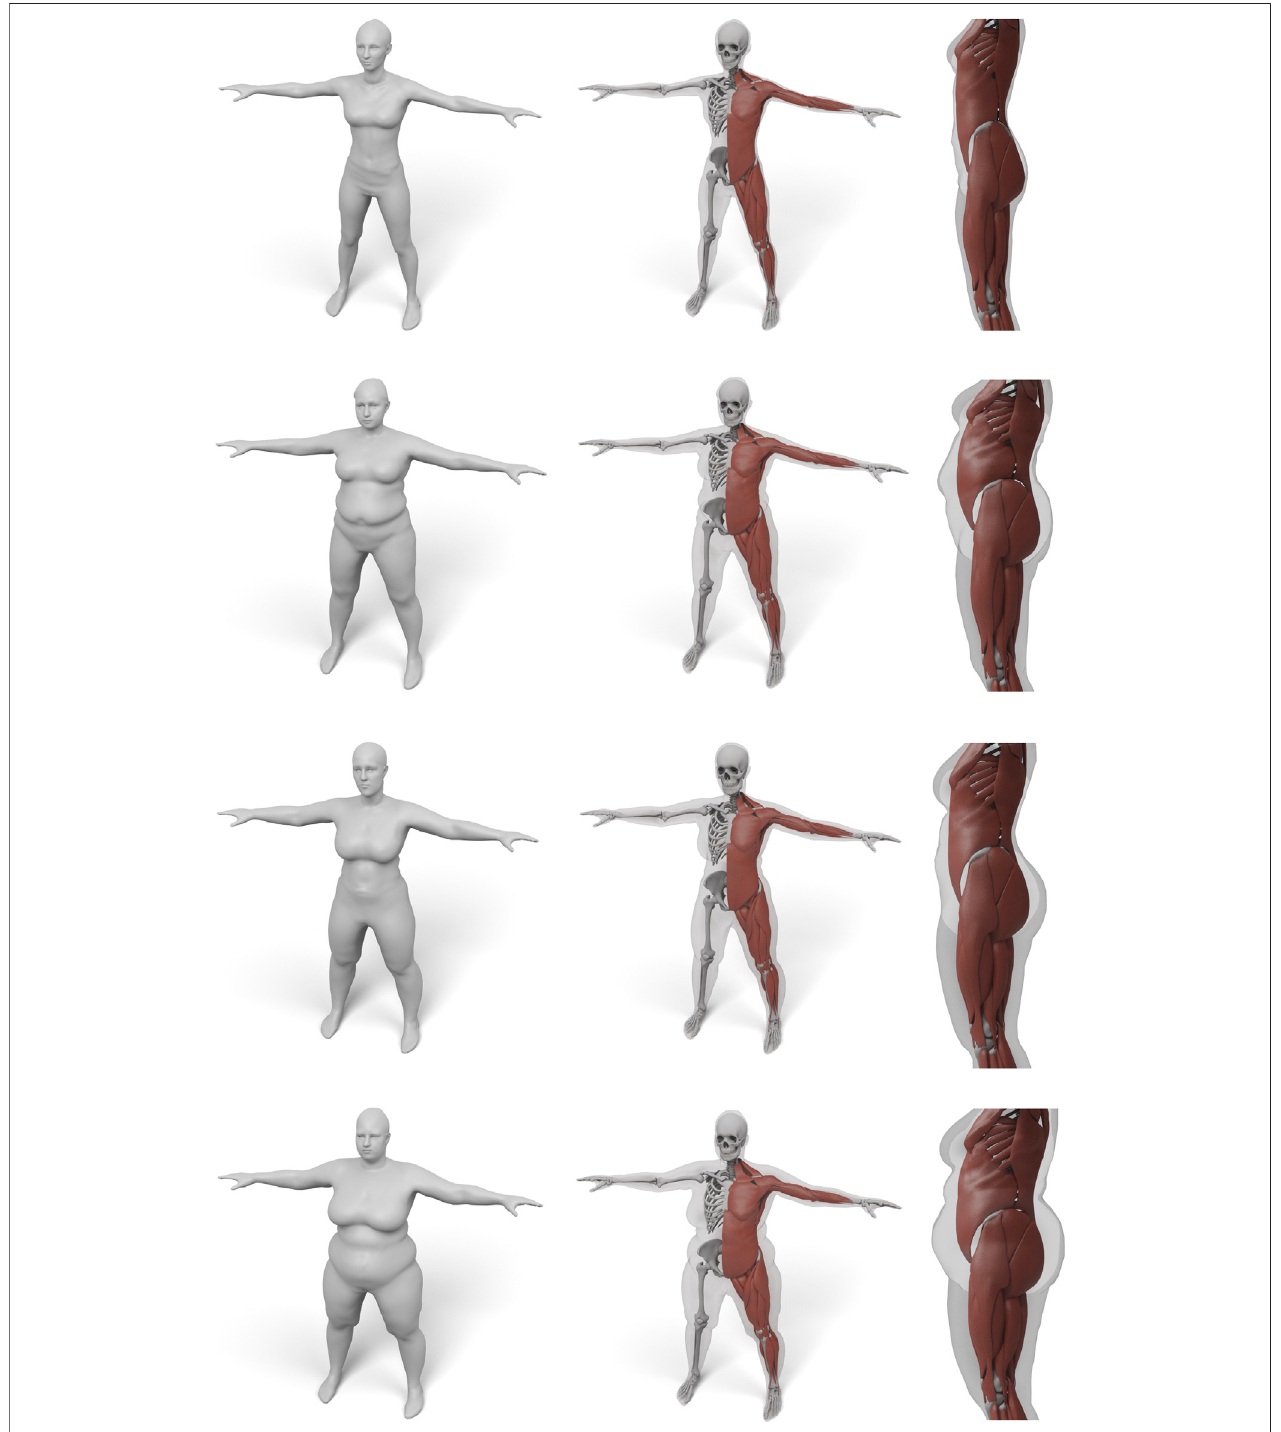
FIGURE 11 | Some examples for various female body shape types. For each input surface the transferred muscles and skeleton are shown in front and side view.